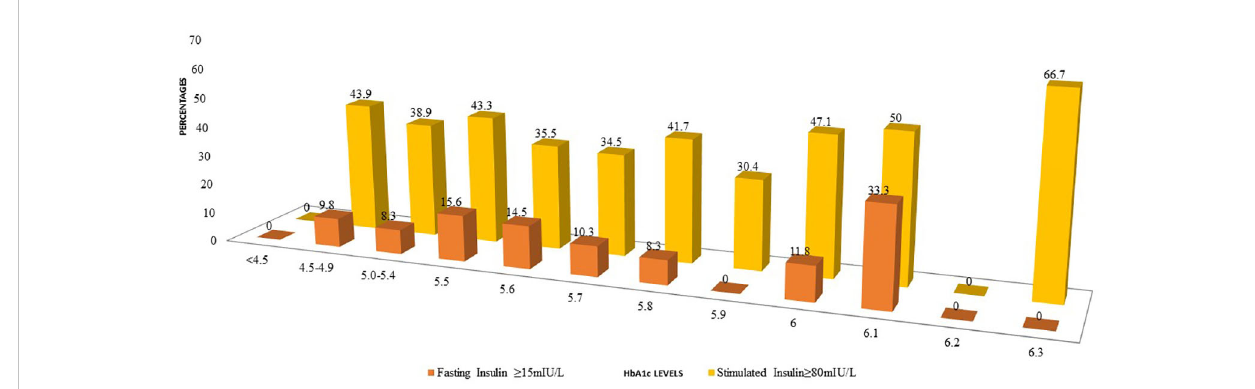
FIGURE 1 Comparison of percentages of participants with elevated fasting insulin or post 2-H stimulated insulin at diffrent levels of